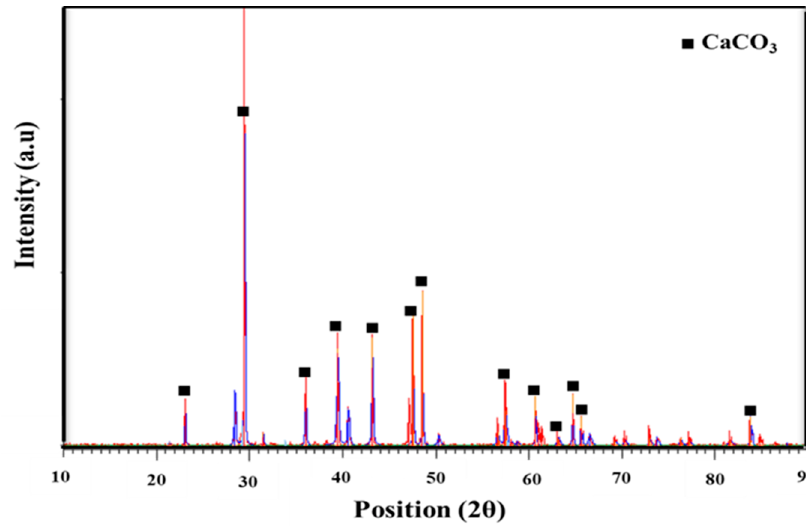
Figure 6. XRD analysis of CaCO 3 .